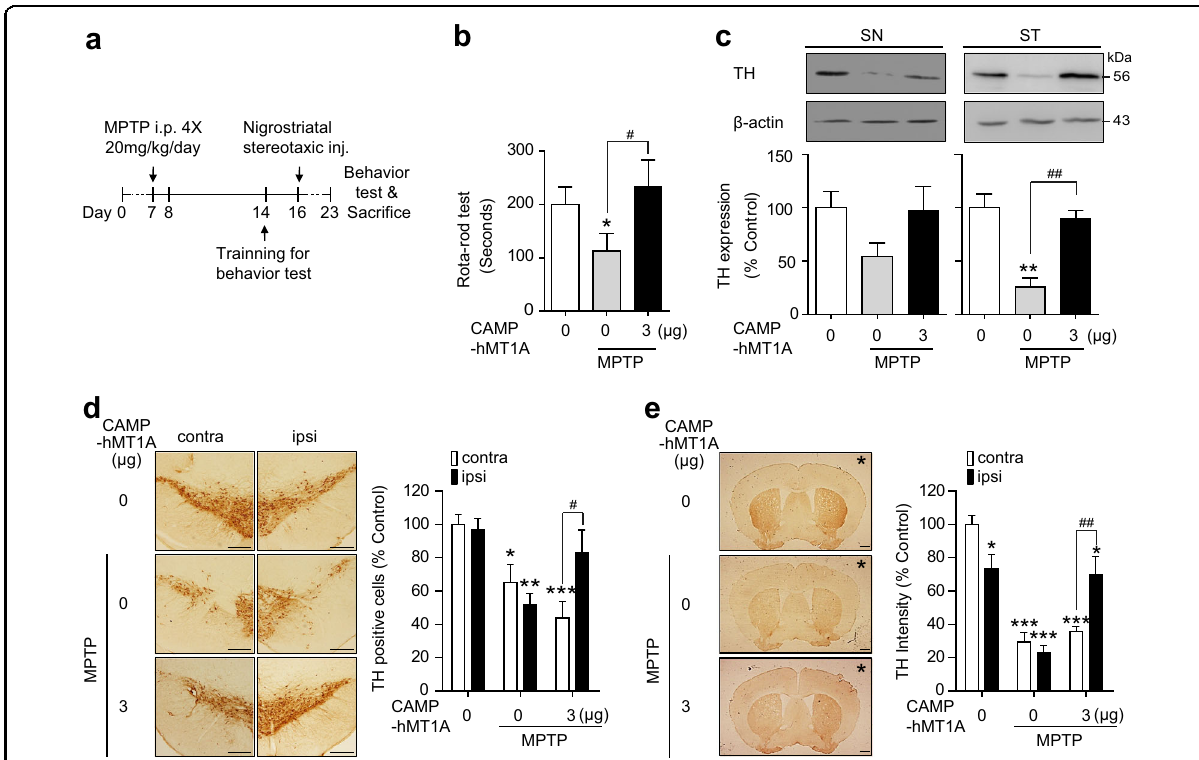
Fig. 7 Sensorimotor function and TH expression are restored by stereotaxic injection of CAMP-hMT1A into SN of MPTP-injected mice. a Timeline of the MPTP-induced PD model experiment. CAMP-hMT1A (3 μ g) or PBS was stereotaxically injected unilaterally into the left substantia nigra. b Rotarod performance test ( n = 7). c Western blot and quanti fi cation of band intensities of TH in the left substantia nigra (SN) or the striatum (ST) ( n = 3). β -Actin was the loading control. d Immunohistochemistry of TH and relative number of TH-positive cells in the SN ( n = 4) (×4, scale bar = 1 mm). e Immunohistochemistry of TH and relative density of TH-positive fi bers in the striatum (×4, scale bar = 1 mm) ( n = 4, *stereotaxic injection site). The data are presented as the mean ± SEM. ipsi ipsilateral side, contra contralateral side; * P < 0.05, *** P < 0.001 vs. control. ### P < 0.001 vs.